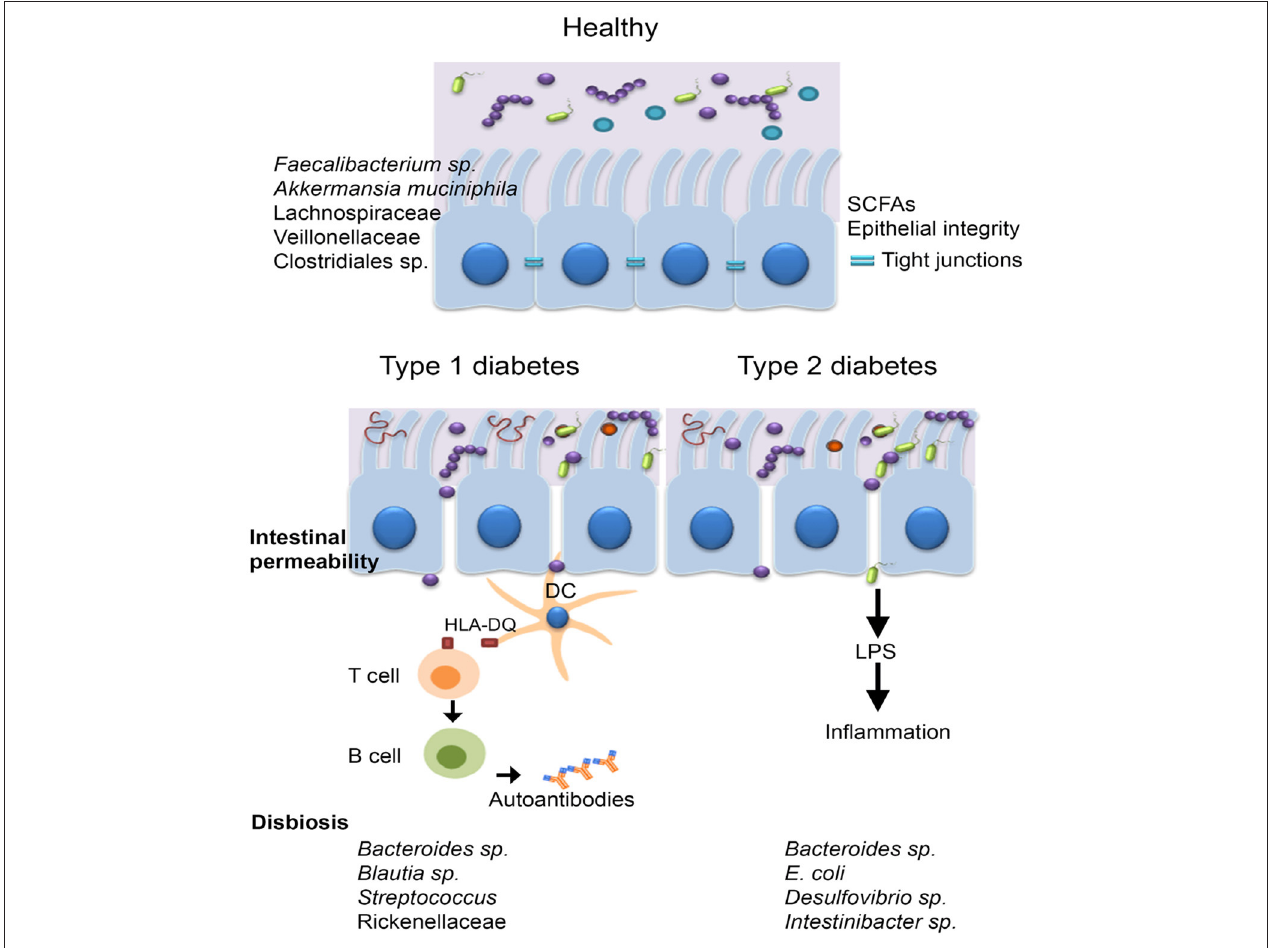
FIGURE 4 | The microbiota of diabetic patients. Individuals with diabetes were reported to have an impaired gut barrier function, characterized by a thinner mucus layer, and increased intestinal permeability. T1DM is an autoimmune disease caused by T-cell–mediated destruction of insulin-producing β -cells, the main genetic predisposition being the human leucocyte antigen (HLA) DR3-DQ2 and DR4-DQ8 haplotypes. Other factors including diet, antibiotic administration, infections, birth delivery mode have all been linked to T1DM development, however the mechanisms involved are not clear. The microbiota of T1DM patients is enriched in bacteria such as Bacteroides sp., Blautia sp. , Streptococcus sp., and Rikenellaceae and low in butyrate producing bacteria, such as Faecalibacterium prausnitzii and mucin degrading bacteria (i.e., Akkermansia muciniphila ). In case of T2DM, disease is generally triggered by lifestyle choices (unbalanced diet characterized by a high intake of refined sugar and saturated fats, sedentarism); individuals with T2DM harbor a microbiota characterized by elevated levels of Bacteroides sp., Intestinibacter sp , Escherichia coli , and Desulfovibrio